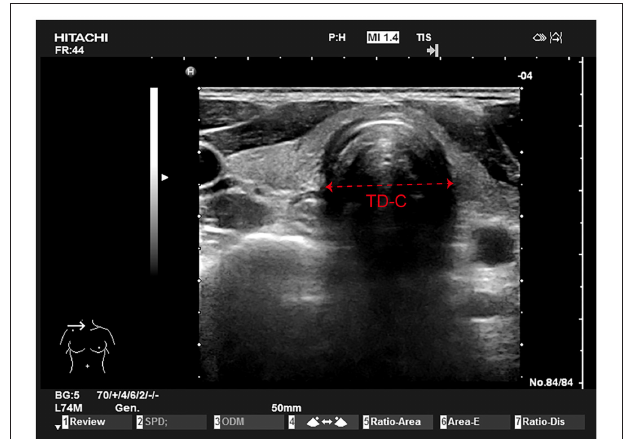
FIGURE 2 | Tracheal ultrasound examination. A linear 5 to 10 MHz probe is placed perpendicularly to the neck just above the sternoclavicular junction in transverse section (left). The outer tracheal diameter is measured on this transverse view